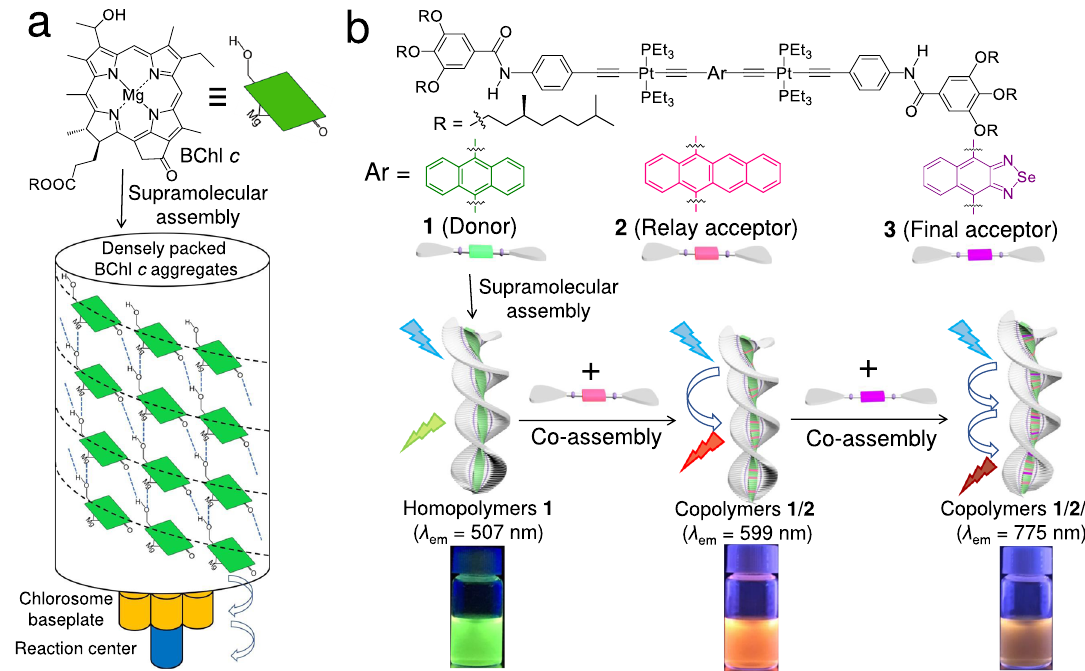
Fig. 1 Natural and arti fi cial sequential energy transfer systems. a Direct supramolecular aggregation of bacteriochlorophyll c (BChl c ) into a light- harvesting antenna, together with the sequential energy transfer process in green photosynthetic bacteria. b Supramolecular copolymerization of 1 , 2 , and 3 (cartoon symbols with green, pink, and purple colors in the middle parts, respectively) with the sequential energy transfer behaviors. The supramolecular homopolymers of 1 emit green light centered at 507 nm. The binary supramolecular copolymers 1 / 2 display orange emission ( λ max = 599 nm) with a one- step energy transfer character. For the ternary supramolecular copolymers 1 / 2 / 3 , sequential energy transfer takes place from 1 via 2 to 3 , giving rise to the emission enhancement in the near-infrared region ( λ max = 775